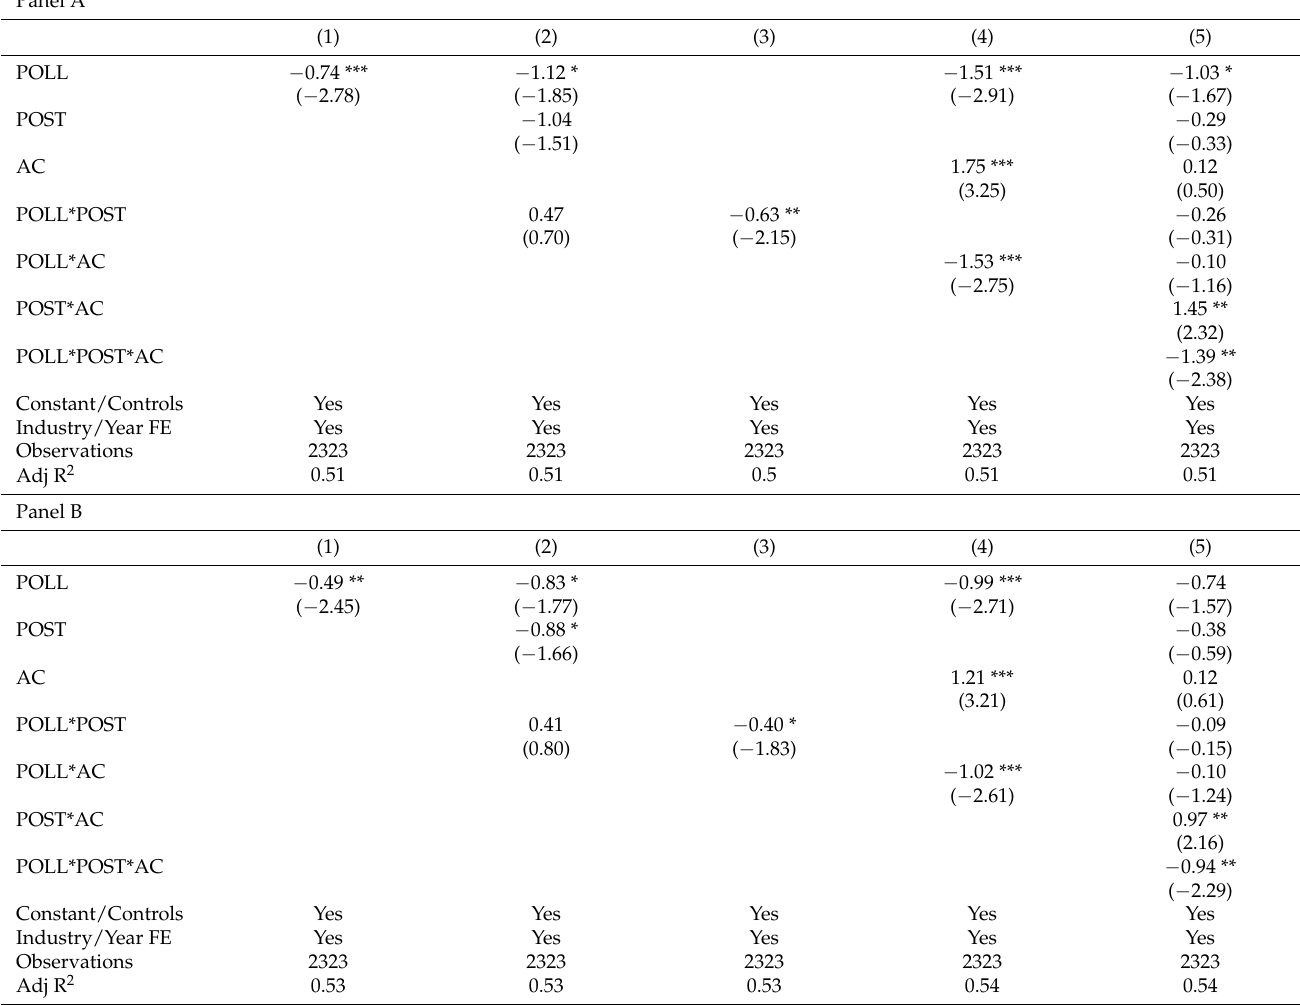
Table 6. Panel A, the role of regulatory change on the effect of carbon emissions and agency costs on firm performance (Dep. var. = TOBQ); Panel B, the role of regulatory change on the effect of carbon emissions and agency costs on firm performance (Dep. var. =